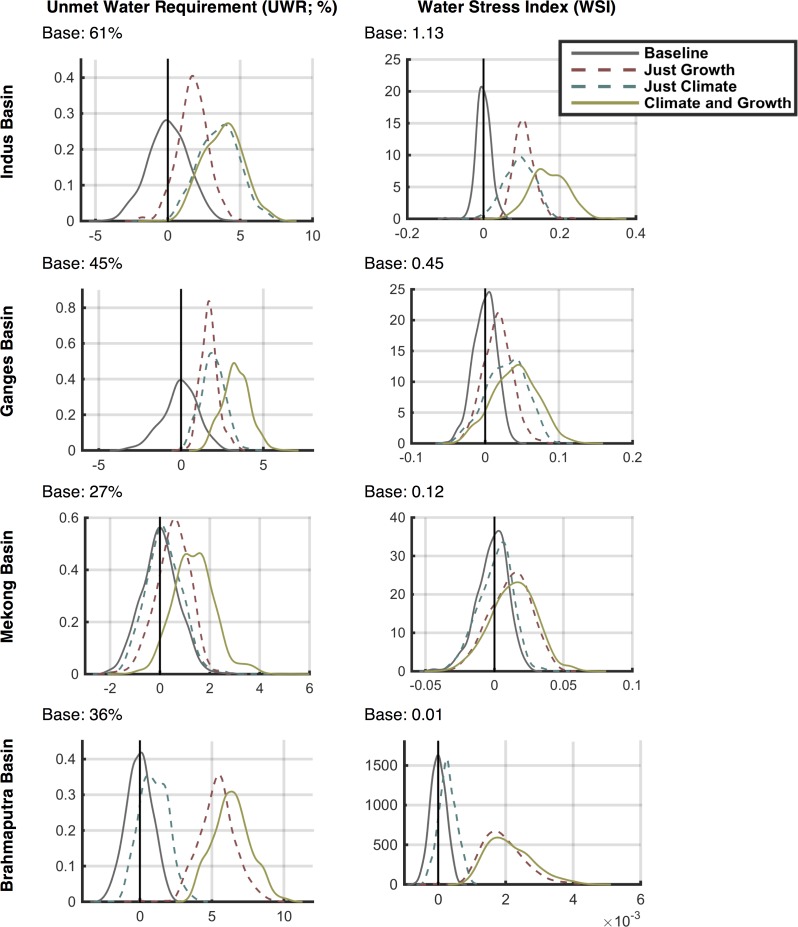
Frequency distributions of changes in decadal averaged Unmet Water Requirement (UWR, left column) and water stress index (WSI, right column) for 2041–2050 against the baseline result aggregated over selected basins (Fig 30) and weighted by population.Mean baseline value shown above each figure. Results are shown for the Just Growth, Just Climate, and Climate and Growth ensemble scenarios. In addition, a distribution for the Baseline result is also provided that depicts the range of UWR and WSI decadal-averaged changes that would result from internal variability of the climate forcing (see text for details).